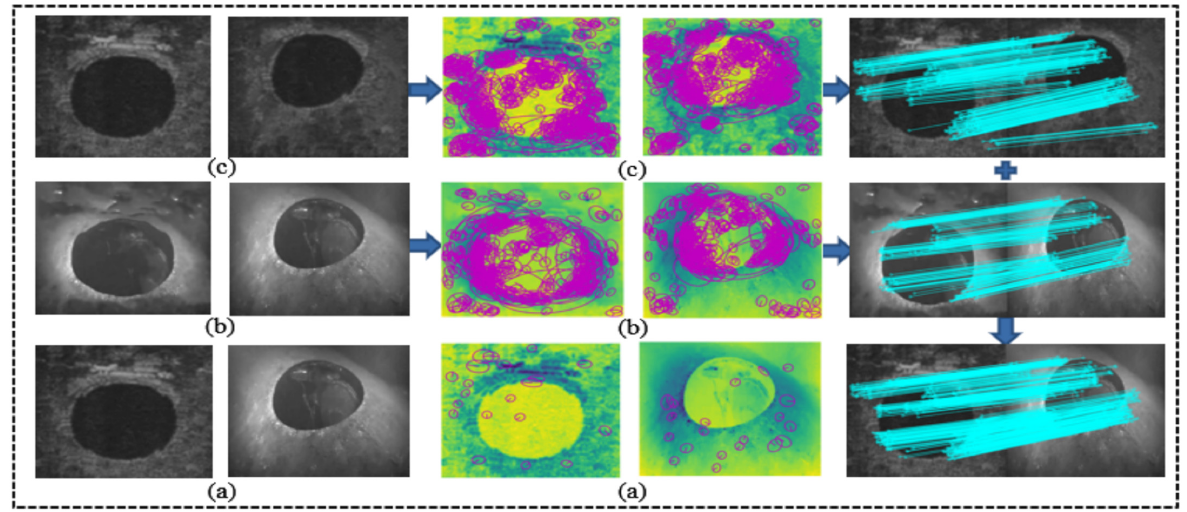
Figure 8. Each image sample in the experiment is tested according to the method described in Figure 8. Due to the limitations of underwater images, such as poor quality, high ambiguity, complex noise, etc., in the matching process we use the RANSAC [38] algorithm and cross-check to improve the accuracy, and the distance ratio is set to the standard value 0.8.